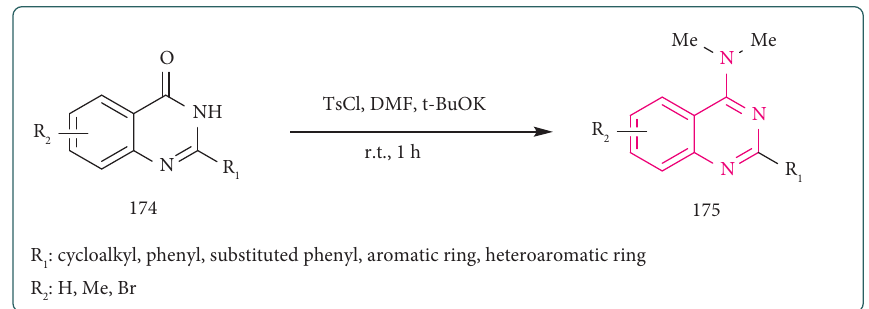
Scheme 33: Synthesis of 4-(dimethylamino) quinazolines via direct amination in the presence of TsCl, DMF, and